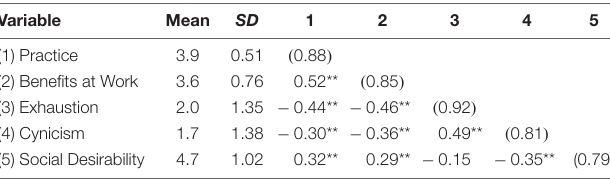
TABLE 3 | Descriptive statistics, correlations, and Cronbach’s alphas.